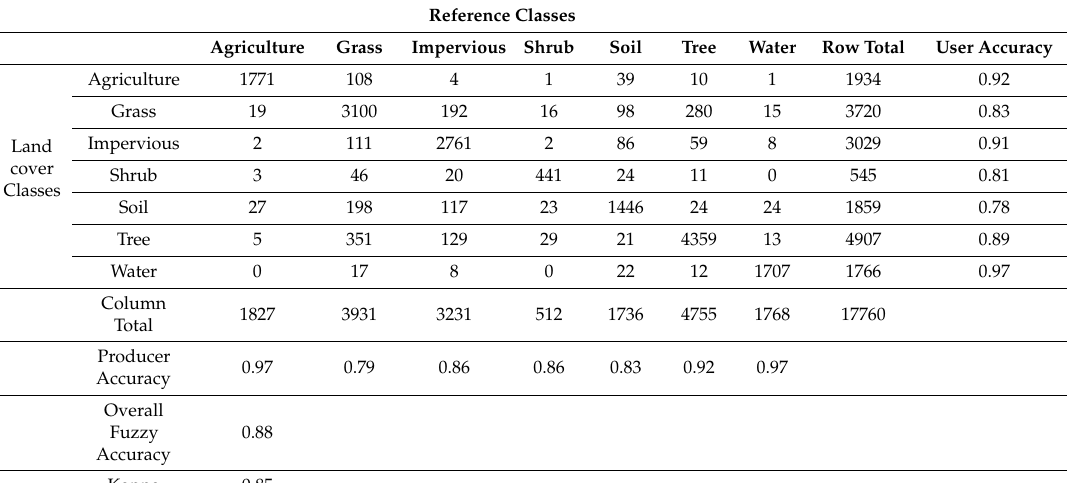
Table 5. Fuzzy confusion matrix for n = 27